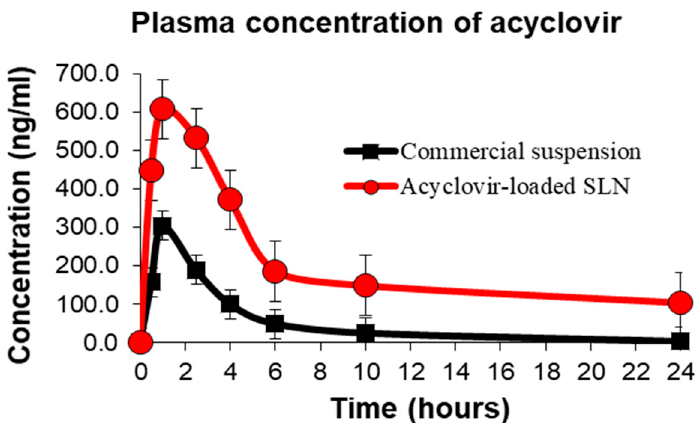
Figure 5. Plasma concentration versus time profile after oral administration of acyclovir-loaded SLNs or commercial suspension in rats. The data represent mean ± S.D. ( n = 6).